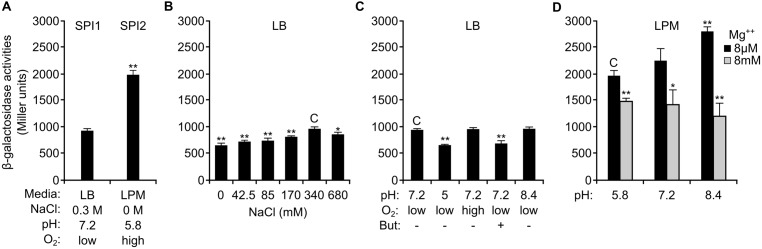
Expression of sseK1 in different culture media. β-Galactosidase activities were measured from overnight cultures of a Salmonella enterica strain carrying a chromosomal sseK1::lacZ translational fusion. (A) Bacteria were incubated overnight at 37°C in LB with 0.3 M NaCl without shaking (SPI1) or in LPM with shaking (SPI2). (B) Different concentrations of NaCl were used to test the role of osmolarity on sseK1 expression under SPI1-inducing conditions. (C) The effects of pH, oxygen limitation and butyrate on sseK1 expression were tested in LB. (D) Activities were measured after growth in LPM with different pH and Mg++ concentrations, as indicated. Means and SD from three independent β-galactosidase measurements are shown. Statistical significance is shown by asterisks representing t-test P values: ∗P < 0.05; ∗∗P < 0.01. C: reference for statistical comparison.